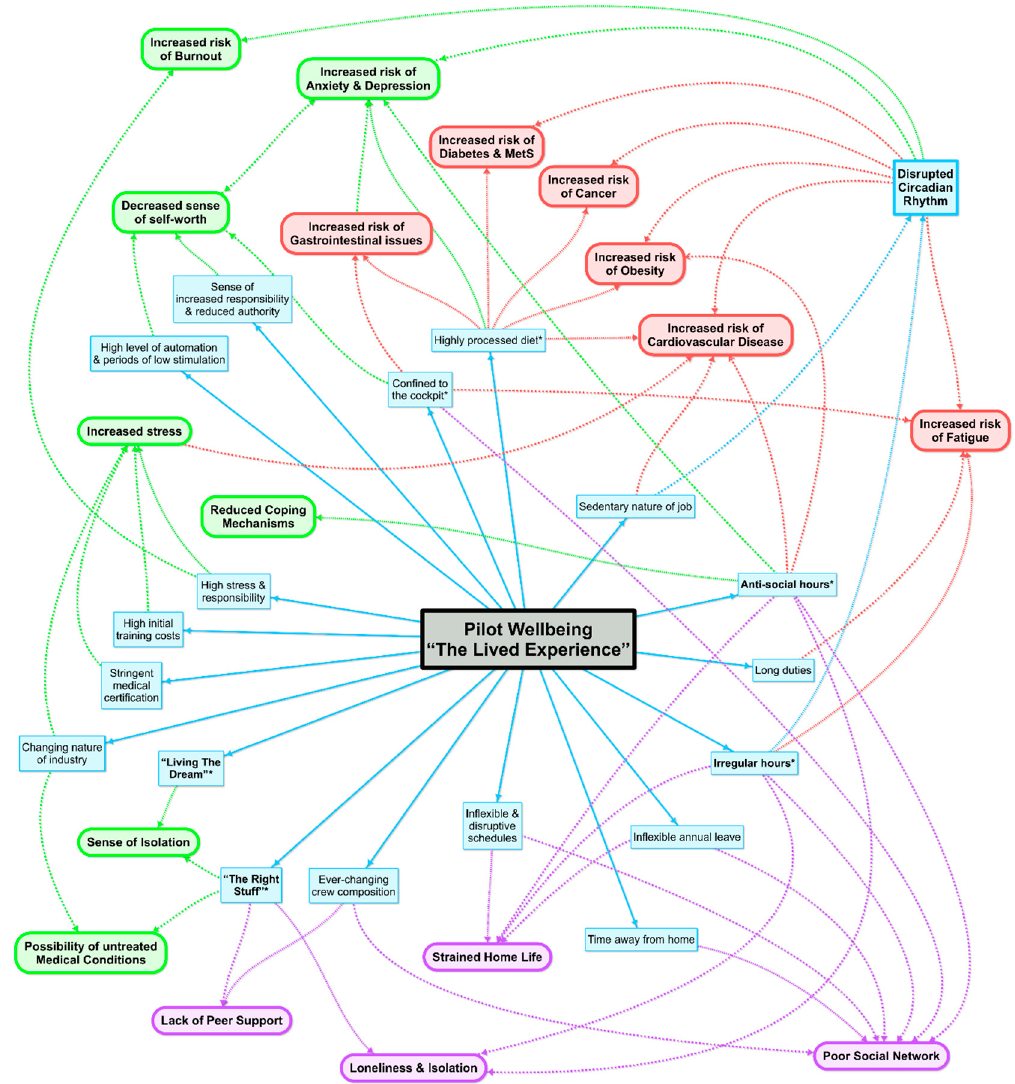
Figure A1. Lived experience model (Cahill et al., 2019).